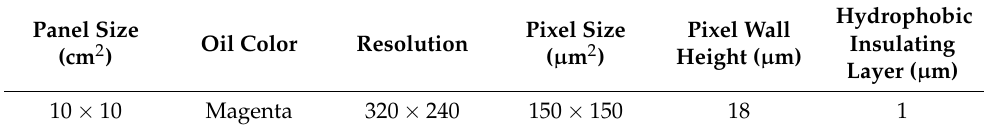
Figure 4. An experimental platform for testing the performance of the EWD. It was composed of a computer, a function generation, a voltage amplifier, a colorimeter, a microscope, and an EWD. The EWD was used as the tested object. The computer, the function generation, and the voltage amplifier were used to generate driving waveforms. Then, the colorimeter was used to obtain the luminance of the EWD, and the microscope was used to obtain the aperture ratio of the EWD. Table 1. Parameters of the EWD used in the